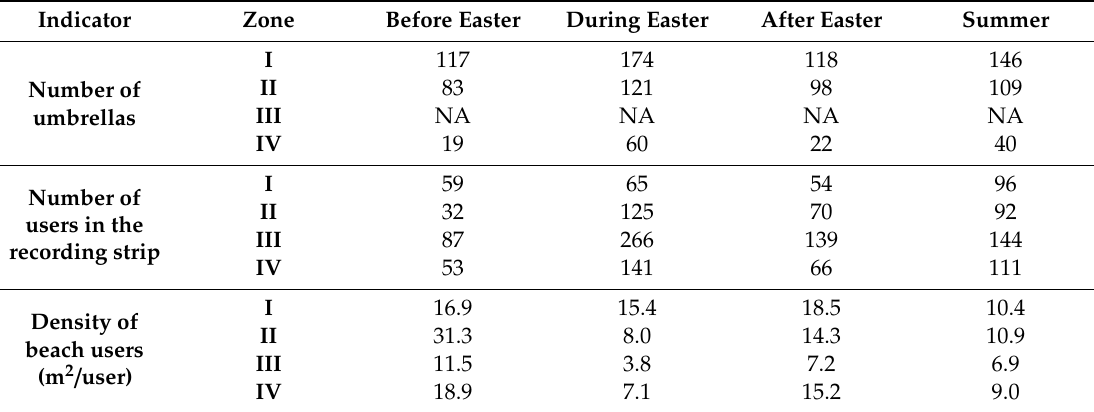
Table 2. Space occupation indicators are shown for the periods before, during, and after Easter, as well as for the summer